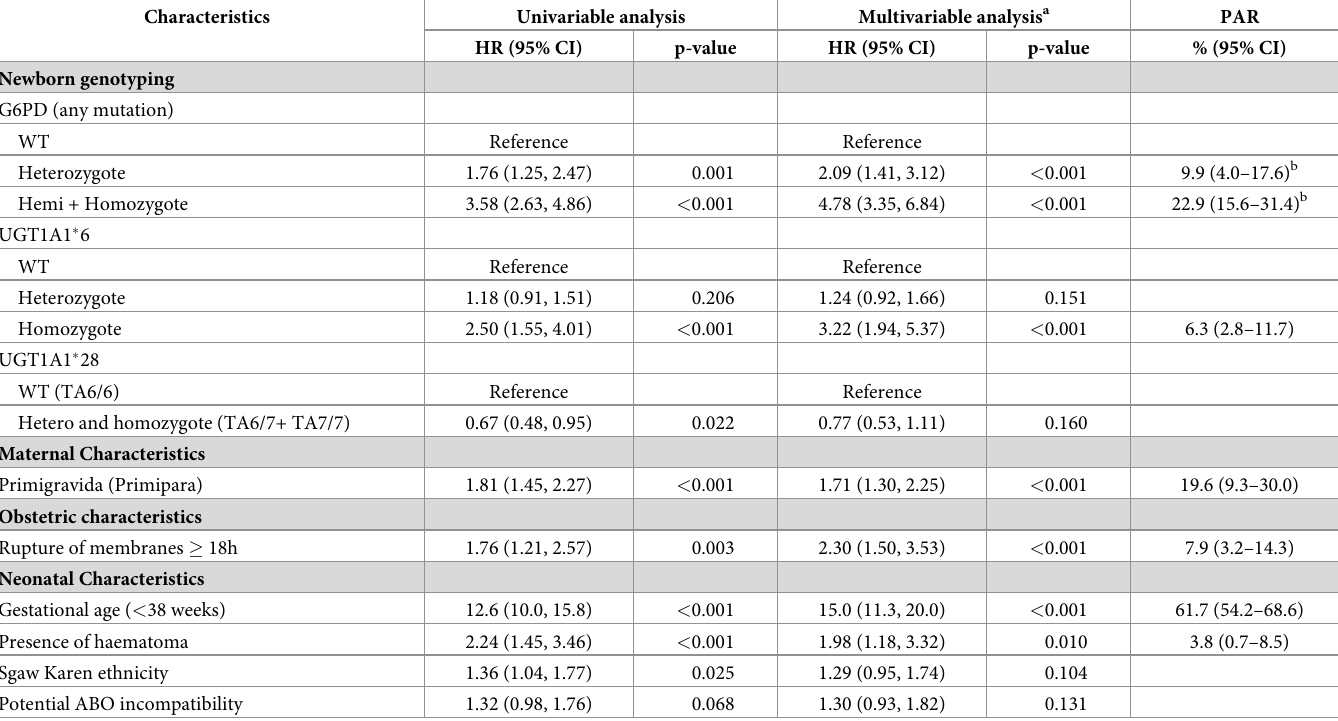
Table 2. Neonatal hyperbilirubinaemia (NH) in the first week of life: Uni- and multivariable analyses of genetic factors and other significant risk factors for devel- oping NH using a mixed effects Cox proportional hazard model clustering by site.